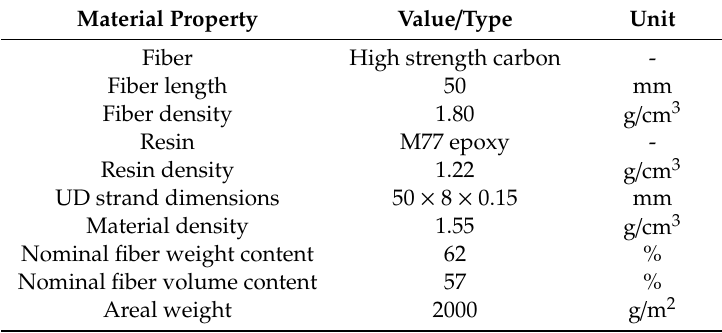
Figure 3. ( a ) HexMC raw material roll; ( b ) HexMC mesostructure with randomly in-plane oriented prepreg carbon / epoxy unidirectional (UD) strands. Table 1. HexMC material properties.